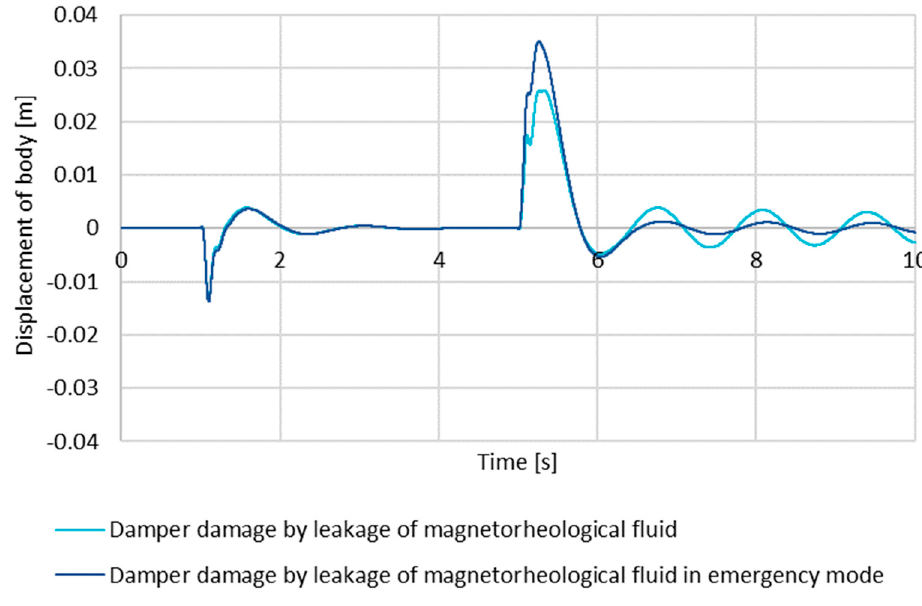
Figure 6. Body vertical displacement for a damper damaged by magnetorheological fluid leakage with switching into emergency mode.